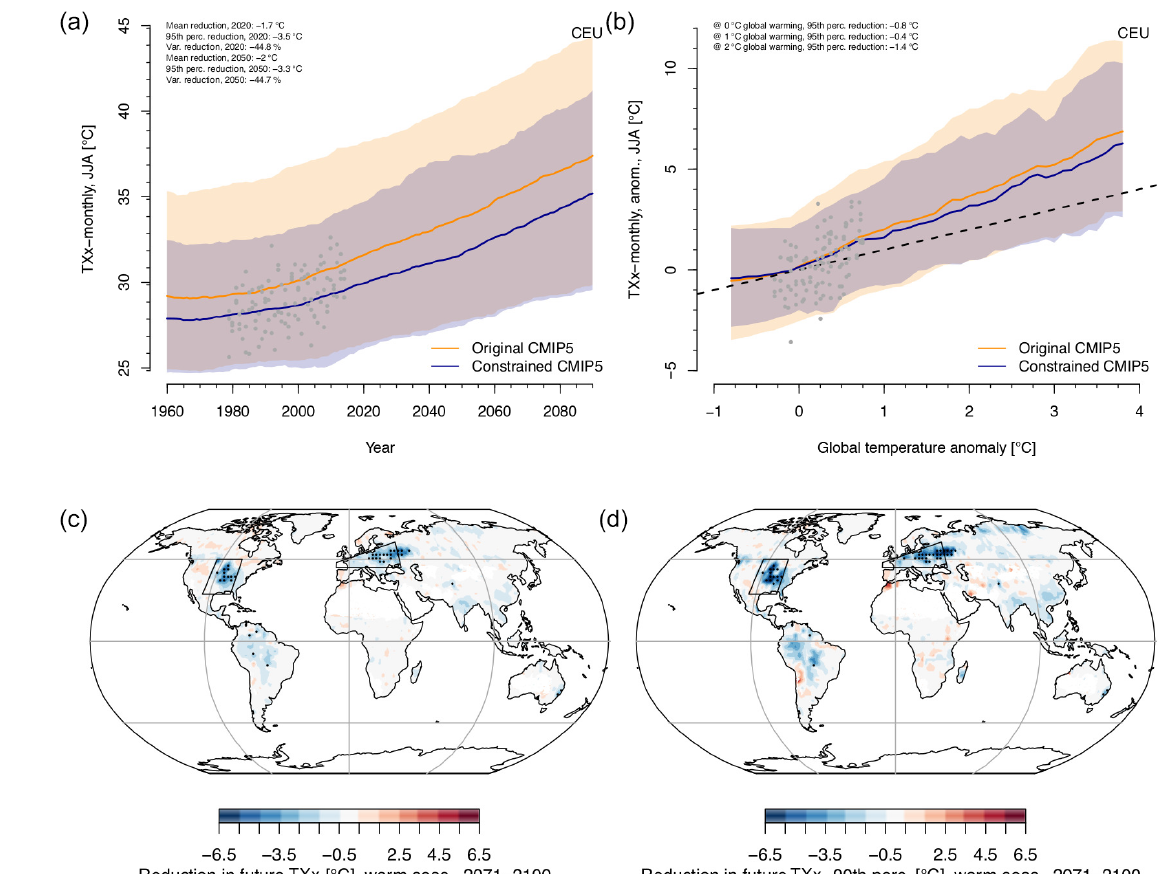
Figure 5. Application of land-coupling constraint to CMIP5 ensemble. (a, b) Ensemble prediction of original and constrained multi-model ensemble for (a) future absolute TXx and (b) range of TXx anomalies relative to global mean temperature anomalies in each model, following Seneviratne et al. (2016). Envelopes indicate 5th to 95th percentile. (c, d) Global maps of projected changes in simulated (c) mean TXx and (d) 90th percentile of TXx in the VACc-constrained CMIP5